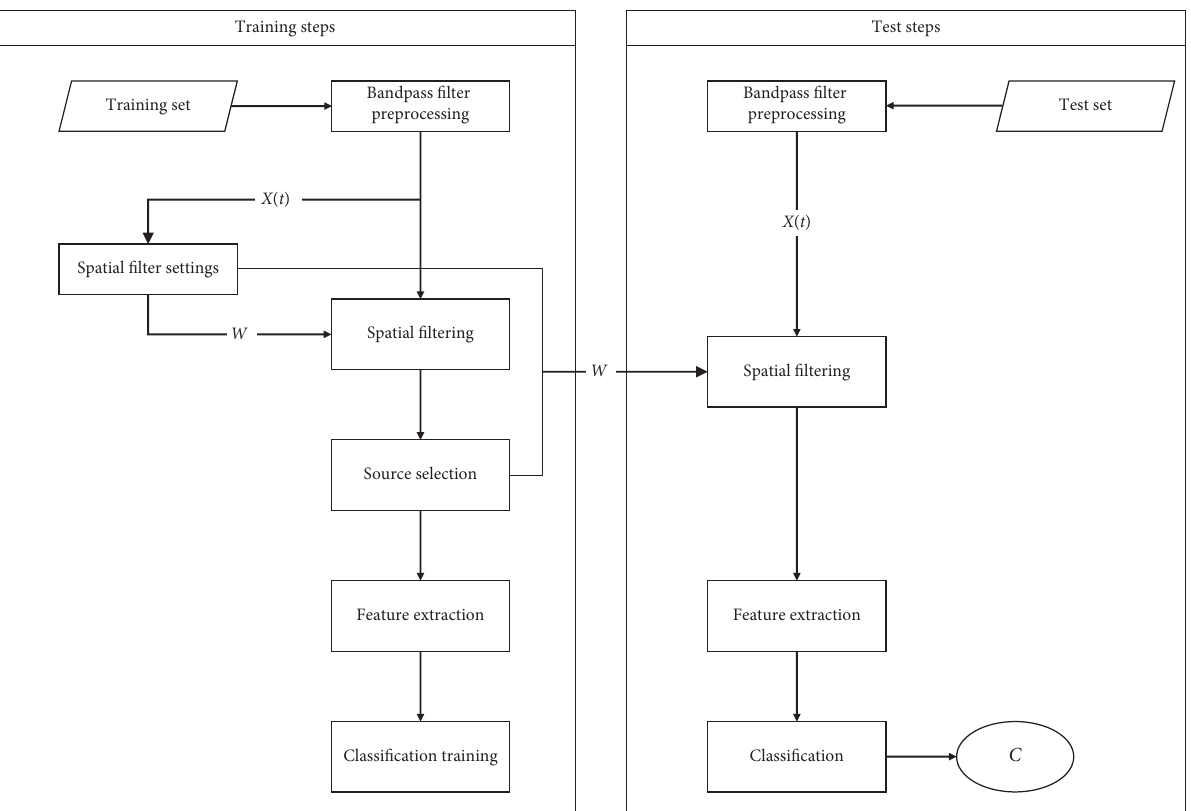
Figure 1: Design and implementation of EEG-BCI based on spatial